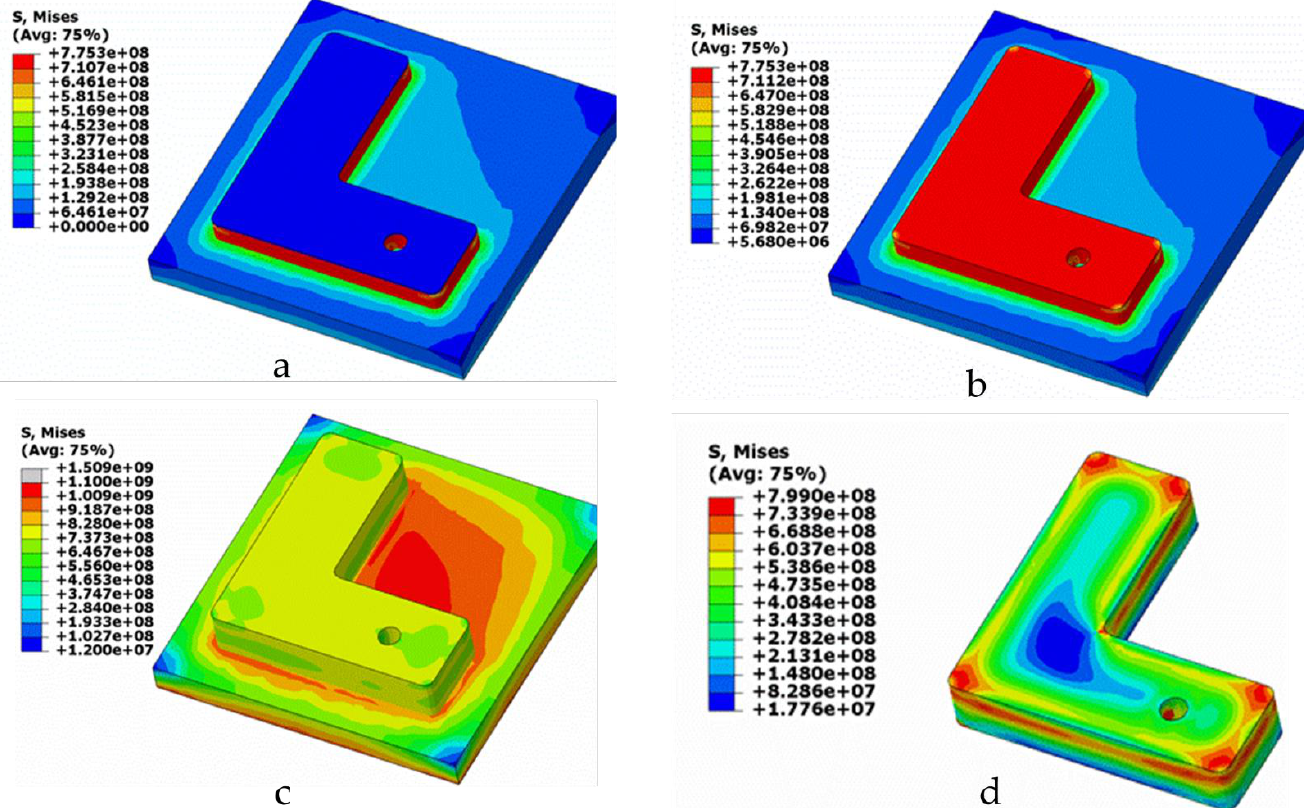
Figure 5. von Mises stress distribution in Pa for horizontally built (HB) sample at various stages while printing ( a ) when a new layer is activated, ( b ) just before a new layer is added, ( c ) when the entire part is cooled down with base plate, and ( d ) after removal of the base plate.